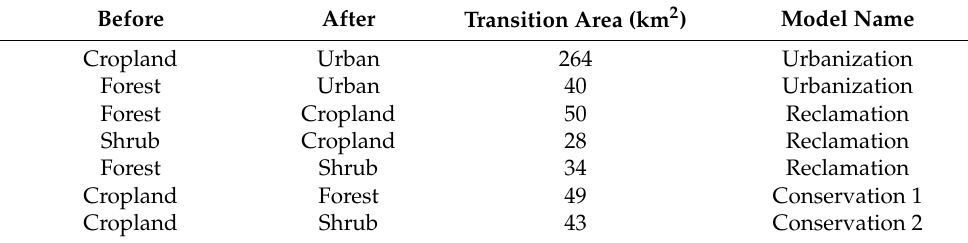
Table 5. Major transitions from 2000 to 2010 and